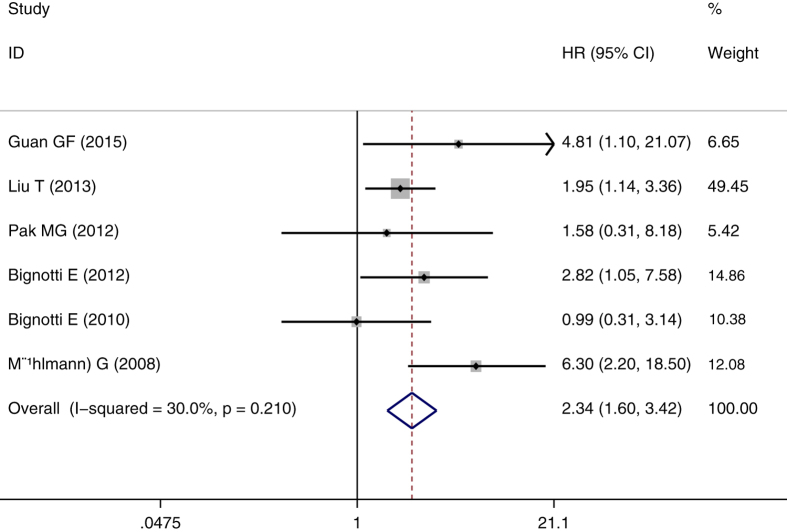
The correlation between TROP2 expression and disease-free survival (DFS) in solid tumors.